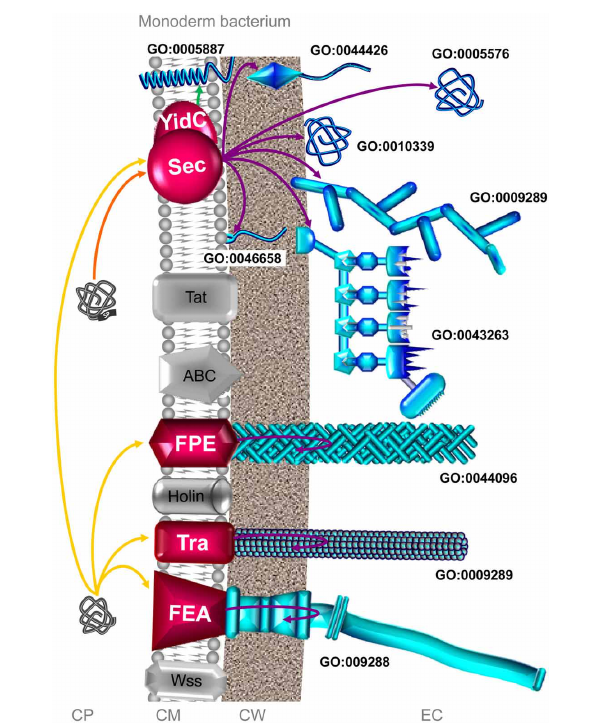
FIGURE 3 | The complement of the secretome involved in colonization process in monoderm bacteria. Among the 8 distinct secretion systems through which a secreted protein can be translocated across the CM, the Sec, FPE, Tra, and FEA pathways can potentially be involved in colonization process in monoderm bacteria (depicted in red). The Sec pathway covers (i) integration of membrane protein (GO:0005887) via YidC, (ii) the anchoring to CM (GO:0046658) via the lipoprotein maturation pathway, (iii) the anchoring to the CW (GO:0044426) in a covalent or non-covalent manner, (iv) the association on the external side of the CW (GO:0010339), (v) the formation of cell surface supramolecular structure, namely pilus (GO:0009289) and cellulosome (GO:0043263), and (vi) protein secretion in the extracellular milieu (GO:0005576). It is worth noting that some proteins with no N-terminal SP can be translocated via Sec in a SecA2-dependent manner in monodermata (Rigel and Braunstein, 2008; Renier et al., 2013). The FPE is involved the formation of Type 4 pilus (GO:0044096). The Tra system (misleadingly called “Type IV-like secretion system” in monoderm bacteria) is involved in the formation of conjugative pili (GO:0009289). The FEA is involved in the secretion and assembly of the flagellum protein subunits (GO:009288). In addition, some surface proteins could use systems as yet uncovered, the so-called non-classical (NC) secretion. Extracytoplasmic proteins, i.e., single proteins and supramolecular protein structures, potentially involved in surface colonization are depicted in blue. Only branches corresponding to the complement of the secretome involved in bacterial colonization are colored. Orange and yellow arrows indicate the routes for proteins targeted to the CM possessing or lacking an N-terminal SP. Violet arrows indicate the routes for exported/secreted proteins (export and secretion are synonymous in monoderm bacteria). Green arrow indicates proteins integrated into the CM. CP: cytoplasm; CM: cytoplasmic membrane; CW: cell wall; EC, extracellular milieu; SP: signal